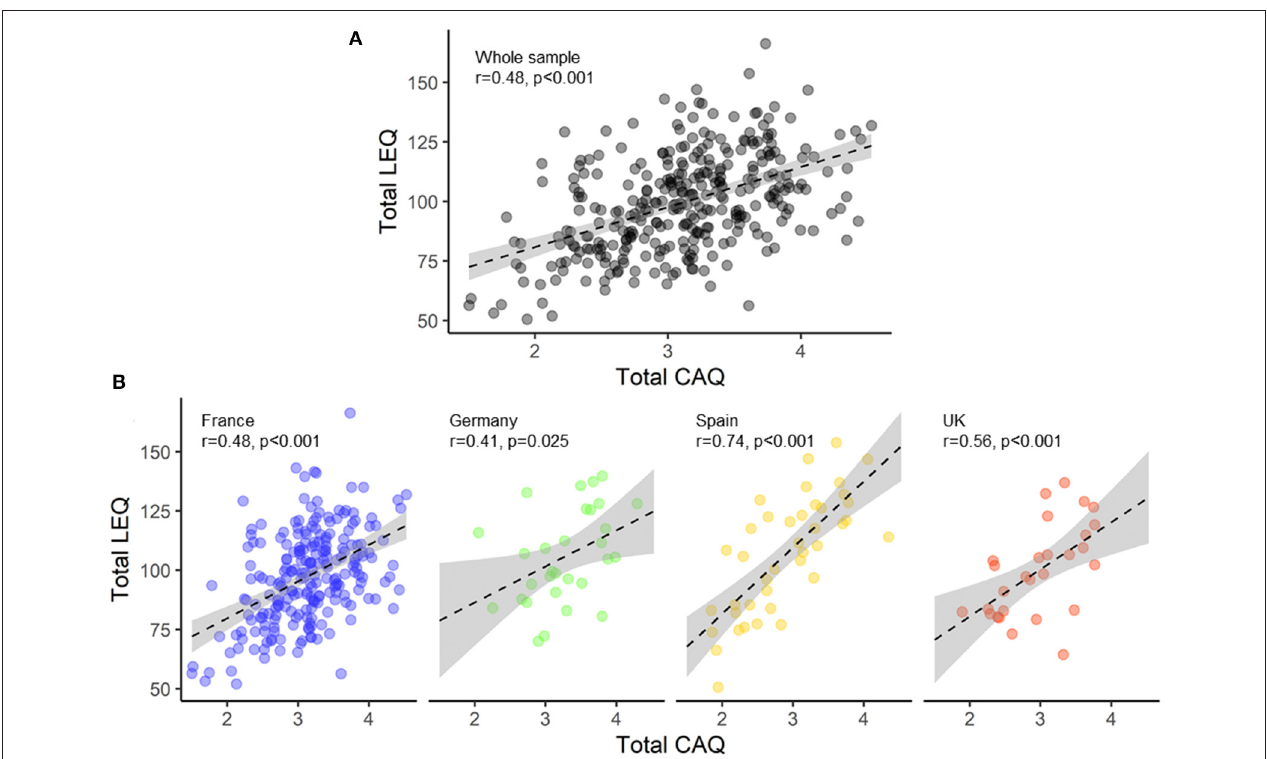
FIGURE 1 | Concurrent validity: scatterplots illustrating the correlation between total LEQ and total CAQ in the whole sample (black) (A) and within each country (France, blue; Germany, green; Spain, yellow; United Kingdom, red) (B) . LEQ, Lifetime of Experiences Questionnaire; CAQ, Cognitive Activities Questionnaire; UK, United